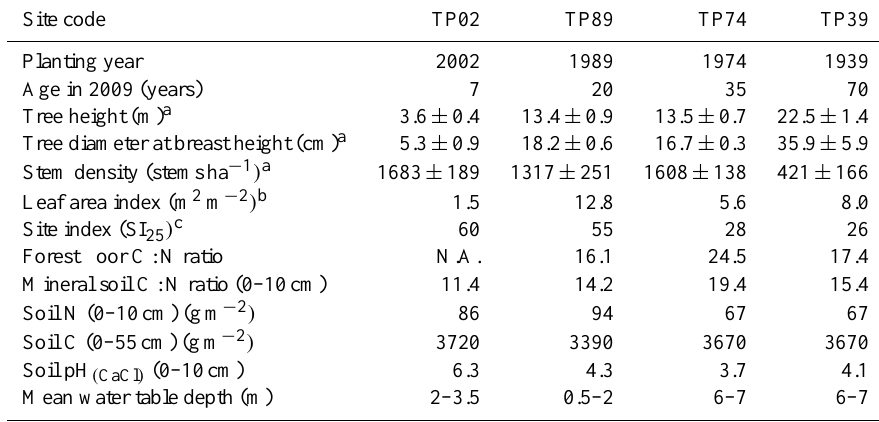
Table 1. Site characteristics of the four Turkey Point pine forest stands (adopted from Peichl et al.,